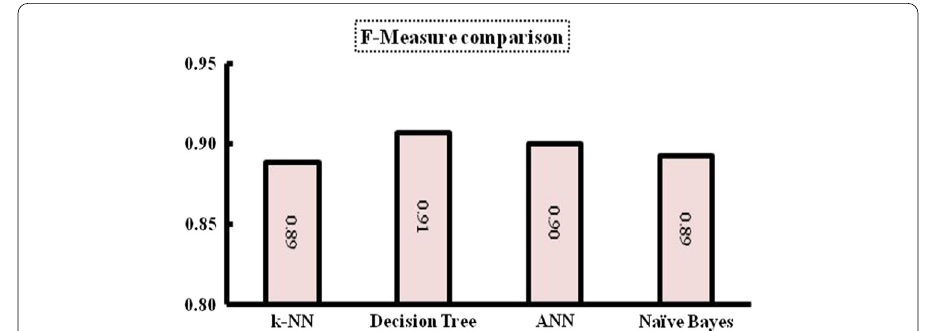
Fig. 4 Comparing F-Measure value of the prediction models